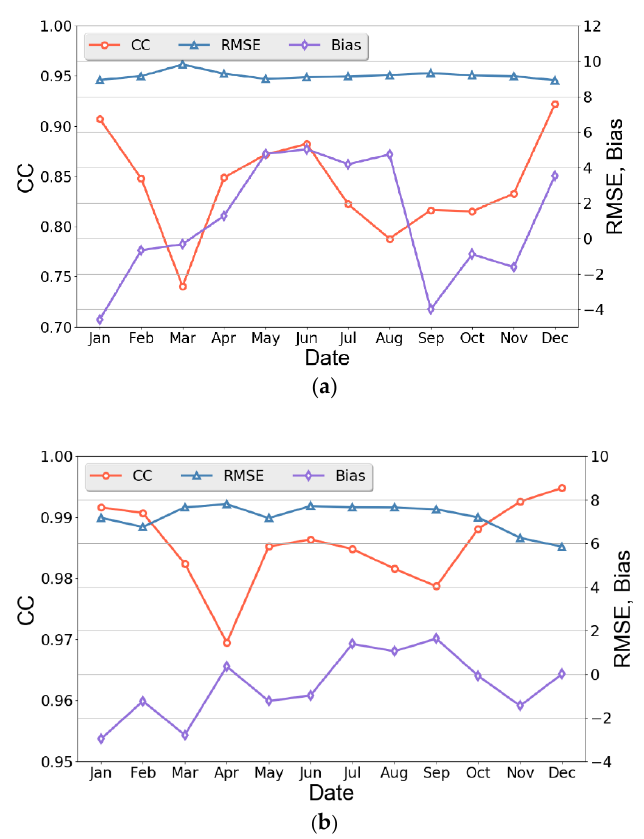
Figure 7. Time series of the CC, bias, and RMSE between the COMS observation and ( a ) AI-generated reflectance, and ( b ) AI-generated radiance at every 25th day in each month from January to December